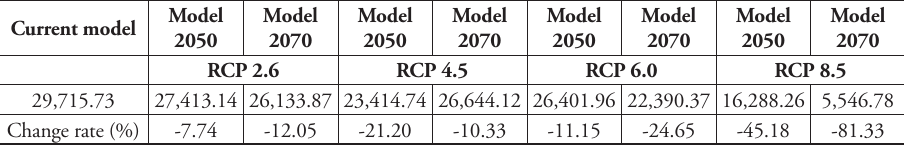
Table 2. Change rate of the habitat suitability area for halophytic grassland in Chihuahuan Desert con- sidering current and future climatic conditions (2050 and 2070) under concentrations of greenhouse